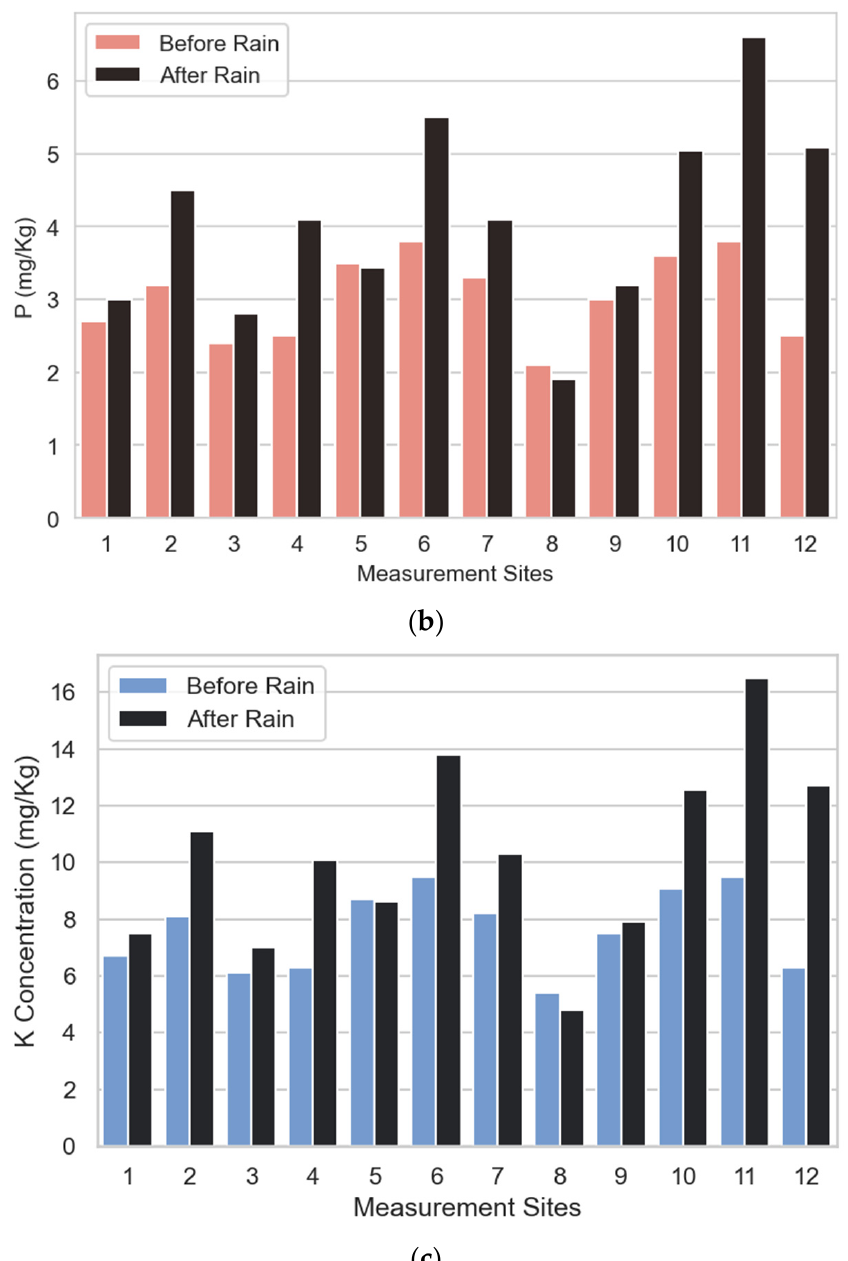
Figure 16. Average soil N, P, and K data before and after rain: ( a ) N data; ( b ) P data; and ( c ) K data. The need for data on other soil parameters (e.g., soil texture, foliage cover, slope of landscape, and drainage) is underlined by data from the correlation matrix of measured soil parameters before and after precipitation (Figures 17 and 18). If, before precipitation, there was a strong correlation of data on soil moisture, electric conductivity, and concentrations of N, P, and K, after precipitation, this correlation slightly